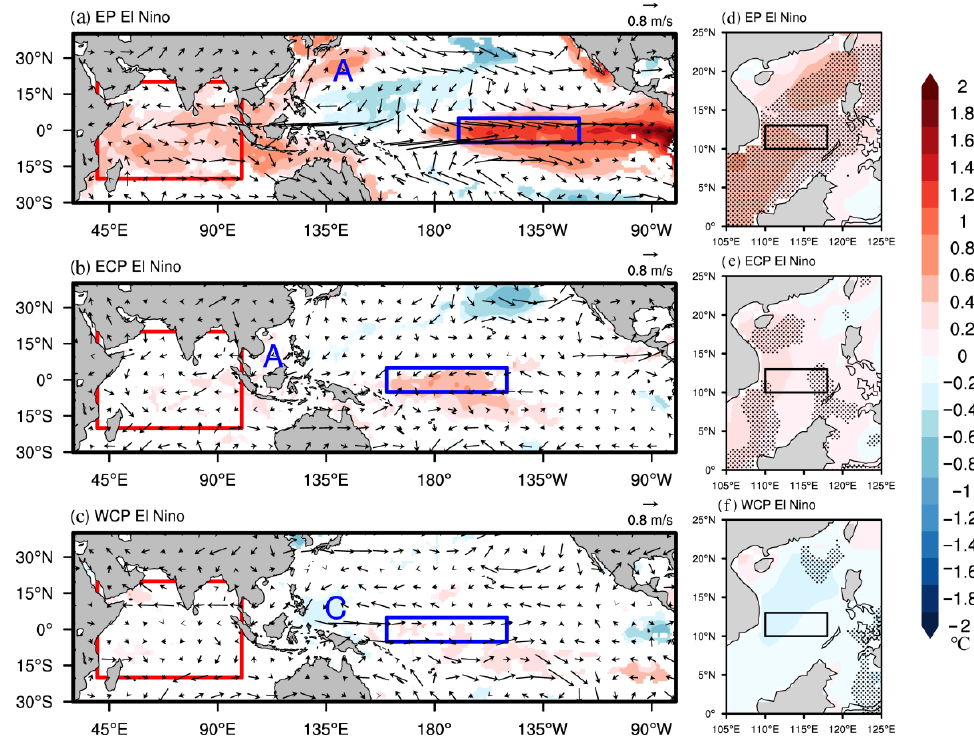
Figure 7. Composite SST anomalies (shaded, ◦ C) over tropical India–Pacific ( a – c ) and SCS regions ( d – f ) during boreal spring (MAM) for ( a , d ) EP El Niño, ( b , e ) ECP El Niño and ( c , f ) WCP El Niño. Only values reaching 85% significance level are shown in ( a – c ), the stippled area in ( d – f ) represents the values exceeding the 85% significance level. Vectors in ( a – c ) show anomalous wind (m · s − 1 ) at 850 hPa. The blue rectangle denotes the Niño3.4 region in ( a ) and the Niño4 region in ( b , c ), with “+” symbols standing for the location of the maximum zonal gradient of the equatorial (5 ◦ S–5 ◦ N) mean SSTA. Symbols A and C in ( a – c ) represent anomalous anticyclone and cyclone, respectively. Red rectangles in ( a – c ) represent the tropical Indian Ocean. Black rectangles in ( d – f ) represent the CT